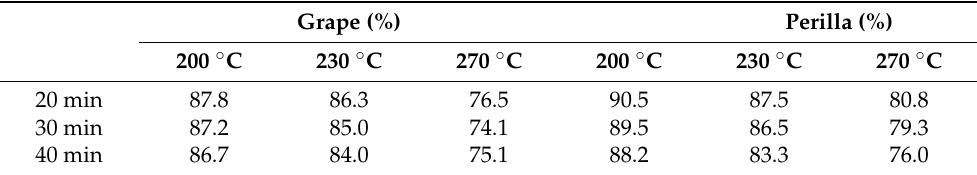
Figure 5. Van Krevelen diagram of torrefied grape and perilla. Table 3. Energy yield of torrefied grape and perilla.